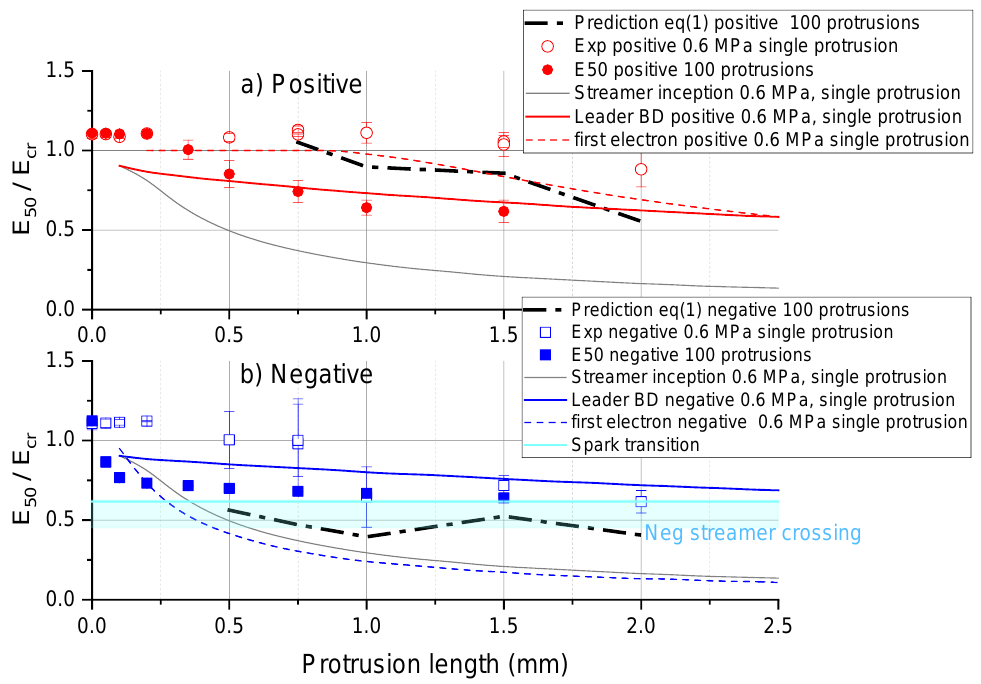
Figure 13. Normalized breakdown fields E 50 / E cr vs. protrusion length L for CO 2 and 100 protrusions at ( a ) positive and ( b ) negative polarities. Not all protrusion lengths could be measured when using multiple